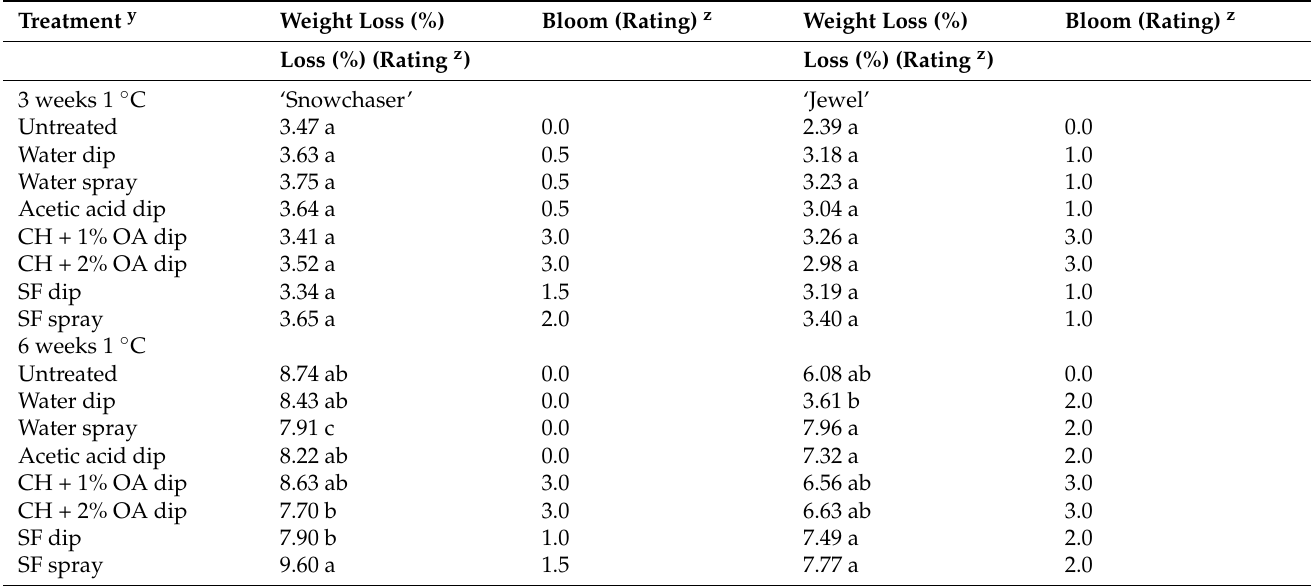
Table 1. Influence of dip or spray coatings on weight loss and berry bloom rating following 3 weeks or 6 weeks at 1 ◦ C in season 1.